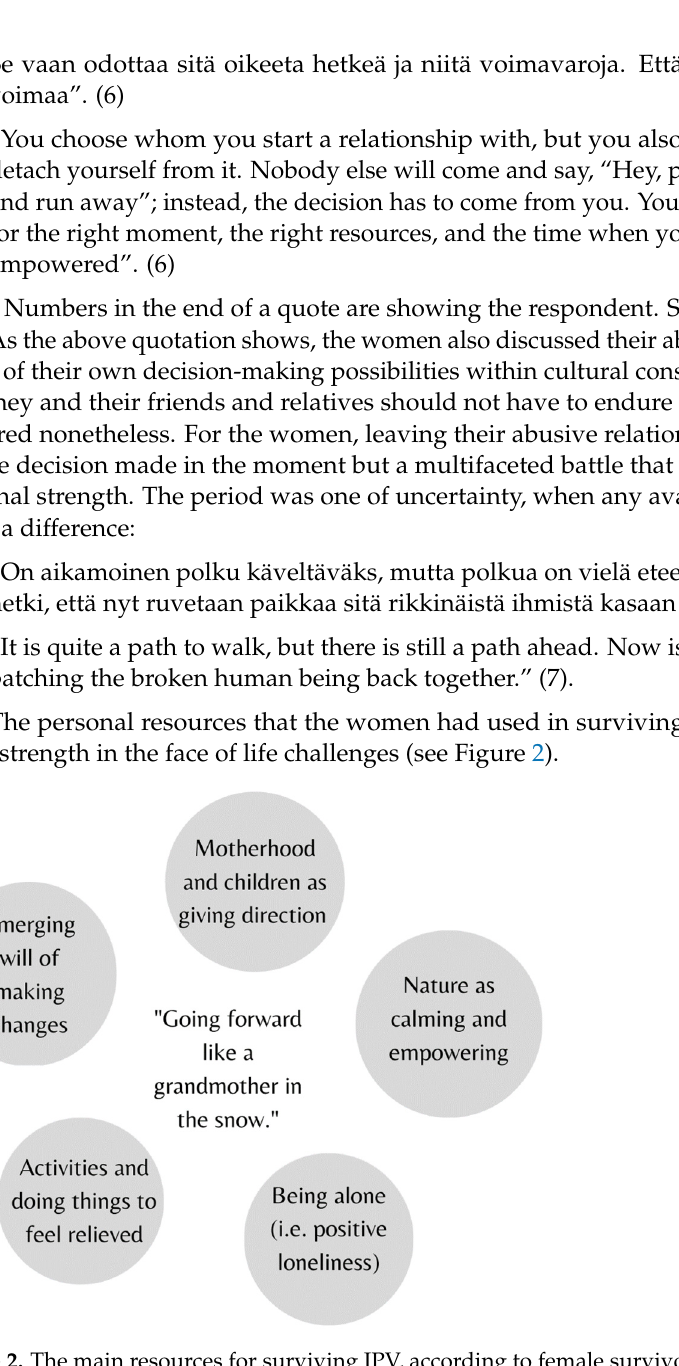
Figure 2. The main resources for surviving IPV, according to female survivors of this study.